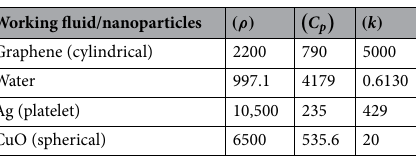
Working fluid/nanoparticles